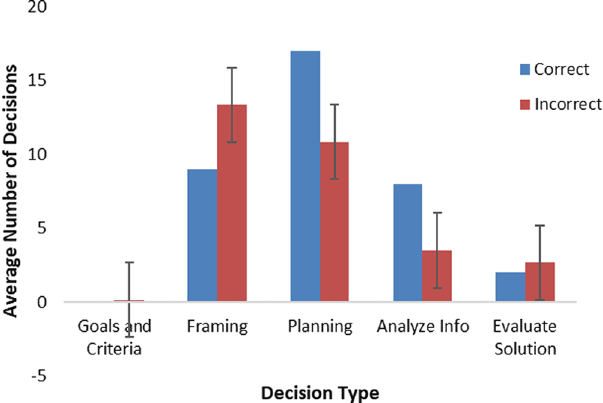
FIG. 4. Average number of decisions made in problem solving think-aloud interviews by students who got the correct answer (blue) and did not (red). Decisions were aggregated into five of the categories outlined in Ref. [23]. Error bars on the incorrect bars represent standard deviations in the number of decisions